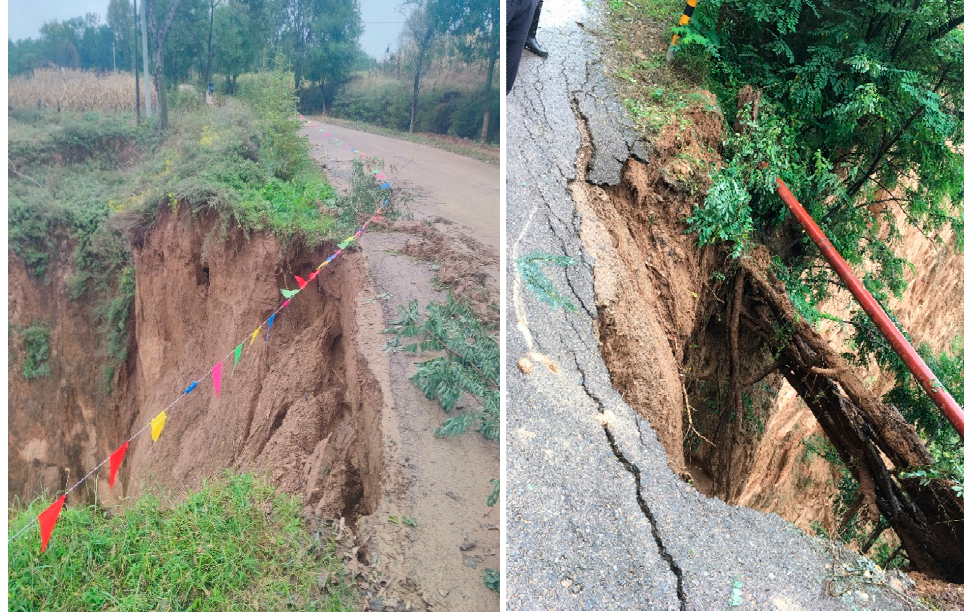
Figure 2. Severe headcut erosion in the study area.